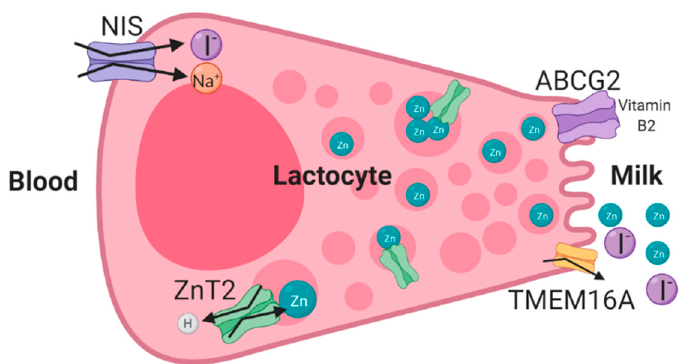
Figure 1. Schematic illustration of the mechanism of transport of micronutrients in human lactocytes during lactation. ATP-driven, multidrug efflux transporter (ABCG2) [38,154], NIS [51,61], and ZnT2 transporter [21,155] were shown to transport riboflavin (vitamin B2), iodine, and zinc, respectively, in human mammary gland epithelial cells during lactation. The anion transporter TMEM16A is predicted to transport iodine into human milk [47,48]. Table 1. Genetic variations that were associated with changes in human milk components, as well as the effect on the infant and suggested treatment. LoF, loss of function; BCRP, breast cancer resistance protein; ABCG2, ATP-driven, multidrug efflux transporter; ITD, iodide transport defect; SNP, single nucleotide polymorphism; HMO, human milk oligosaccharide.